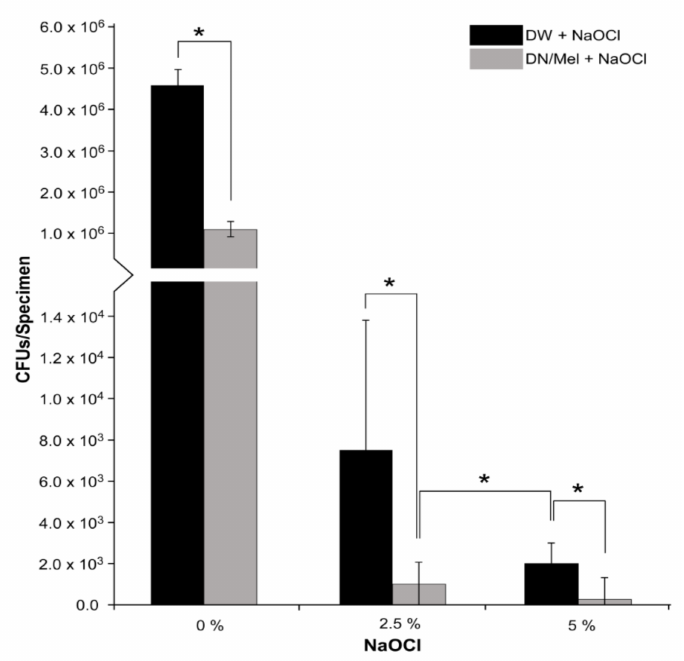
Figure 4. Synergistic e ff ect of NaOCl with DNase and melittin (DN / Mel). Statistically significant p < 0.05 (*). DW: distilled water, DN: DNase, Mel: melittin, NaOCl: sodium